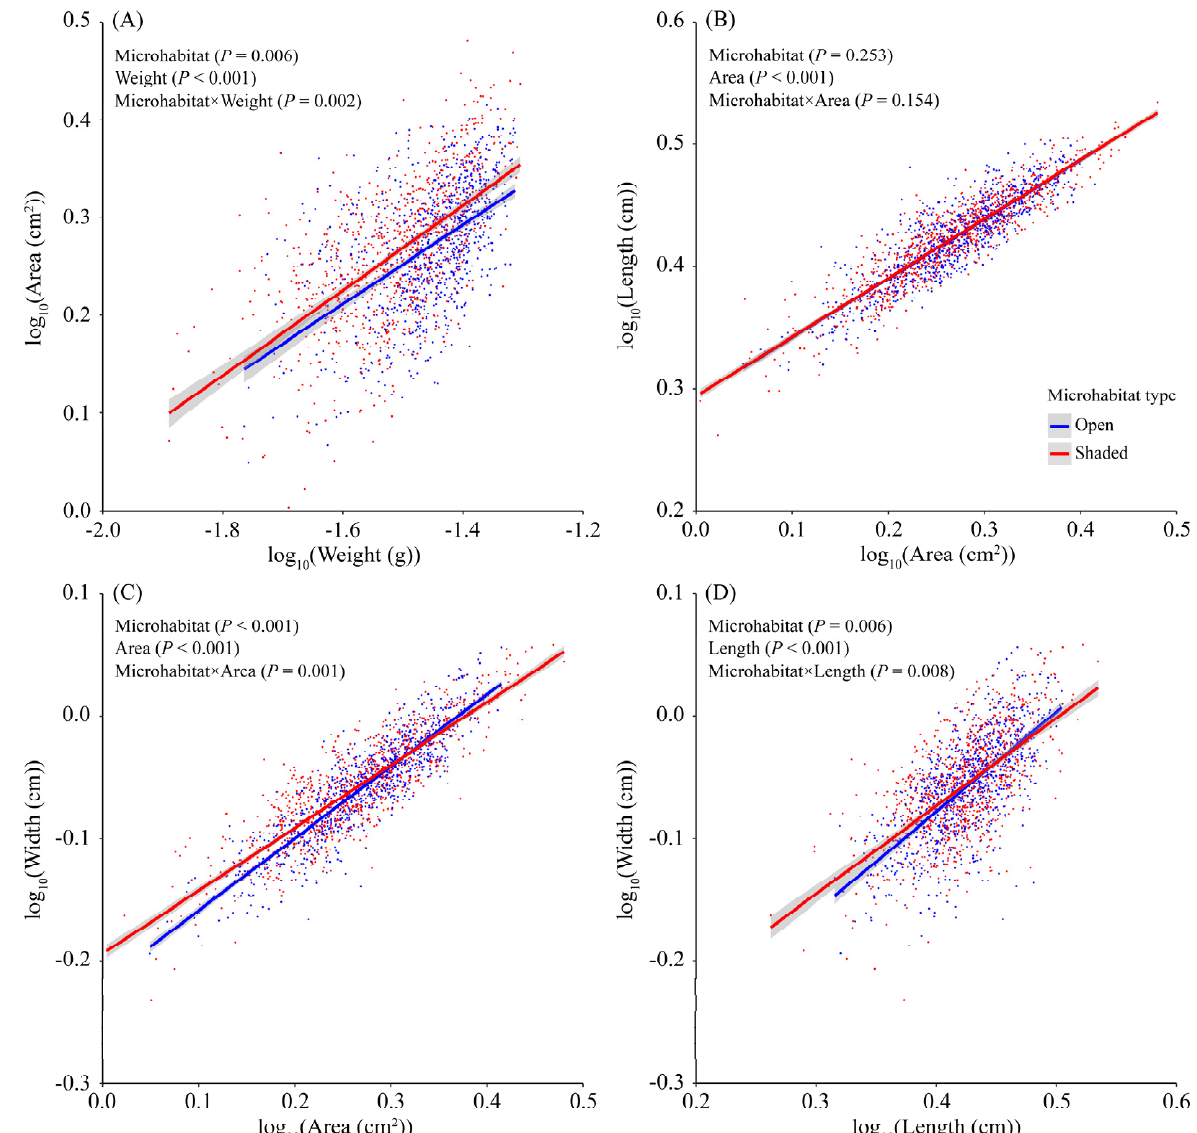
Figure 4. Morphological allometries of samaras of Acer palmatum trees in response to different maternal microhabitat light conditions. The allometries include ( A ) area-weight, ( B ) length-area, ( C ) width-area, and ( D ) width-length relationships in log-log scales. In each analysis, log10-transformed properties in y-axis and x-axis are respectively set as the dependent variable and the covariate. In the corresponding linear mixed model, microhabitat type, covariate and their interaction term are the fixed factors, and site and tree are the random factors. The significance of the fixed effects is presented here as p values, which were calculated based on type-III analysis-of-variance.